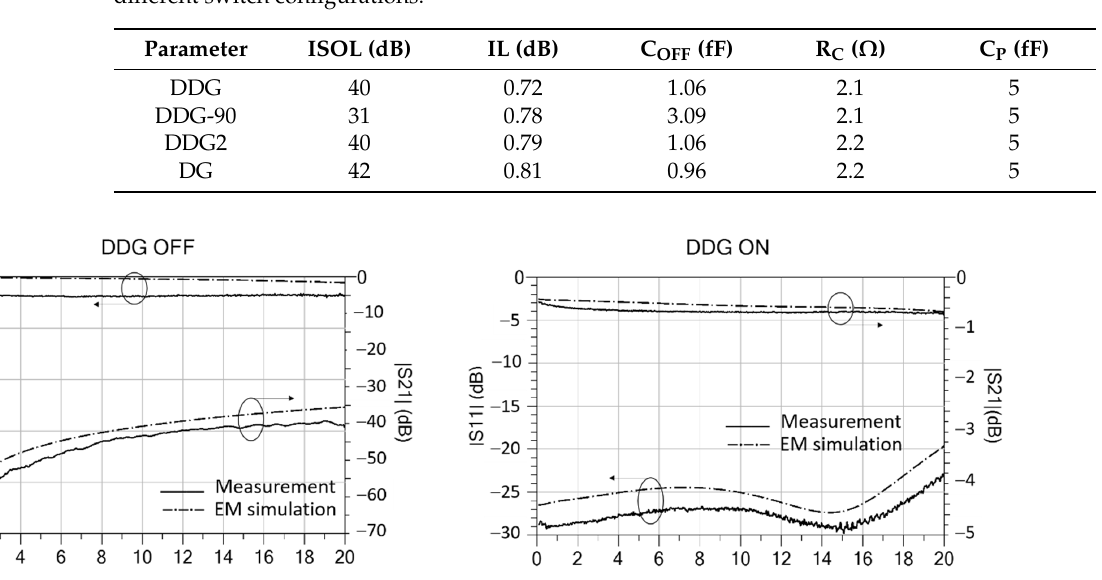
Table 5. Summarized measured performance at 20 GHz and equivalent-circuit elements for the different switch configurations.